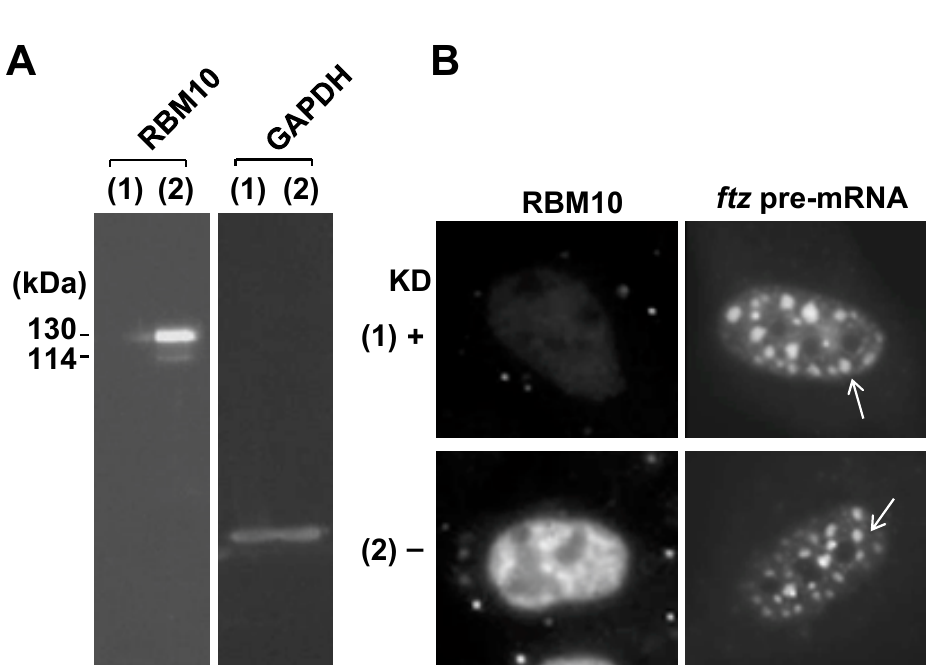
Figure 7. RBM10 is not essential for structural organization of S1-1 NBs. ( A ) HeLa cells were treated with RBM10-specific siRNA (1) or control AllStar siRNA (2) for 3 days, and expression of RBM10 and GAPDH in these cells was examined by immunoblotting. Molecular sizes of the 930- and 852-aa isoforms are indicated in kDa on the left. ( B ) Nuclei in siRNA-treated HeLa cells were microinjected with Cy3-labeled ftz pre-mRNA, and the cells were incubated with 5 µ g/mL Act D for 2 h. Fluorescence images show RBM10 stained with anti-S1-1/RBM10 antiserum (left panels) and Cy3-labeled ftz pre-mRNA (right panels). Arrows indicate representative enlarged S1-1